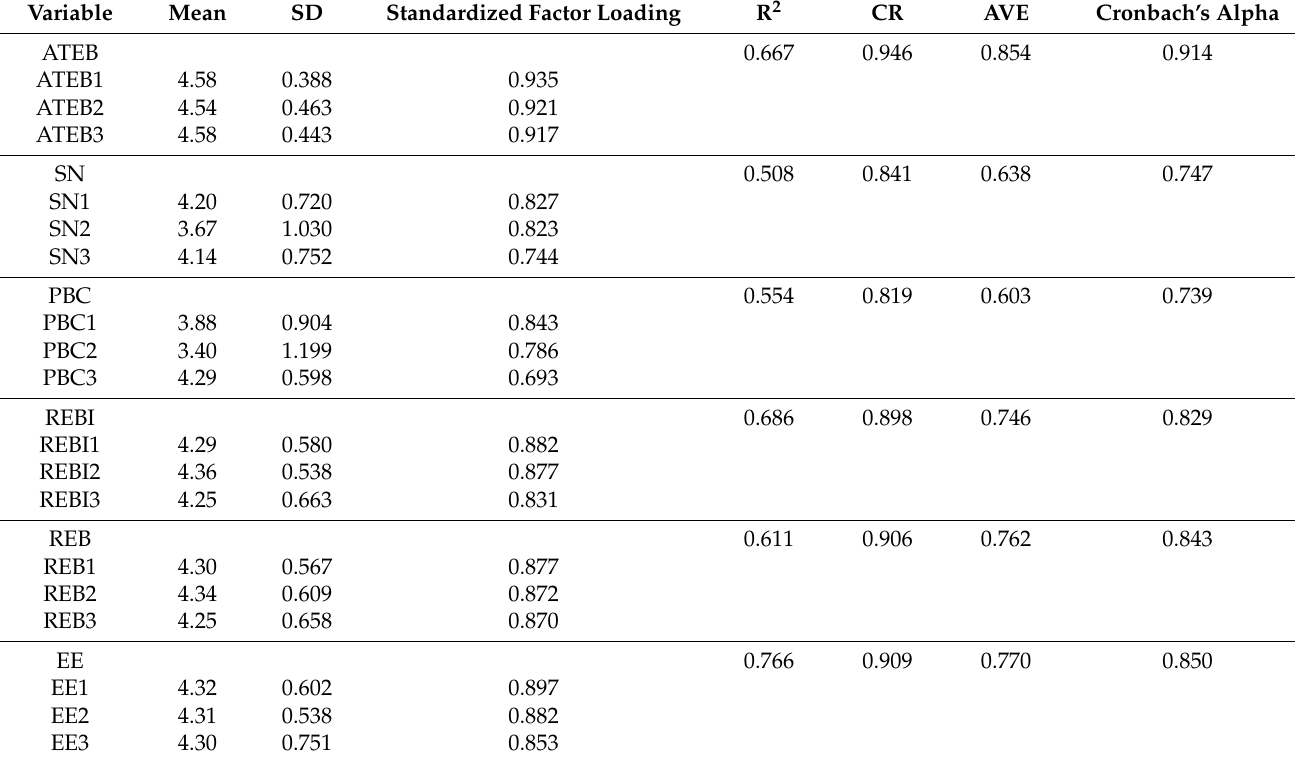
Table 6. Reliability and convergent validity test results.